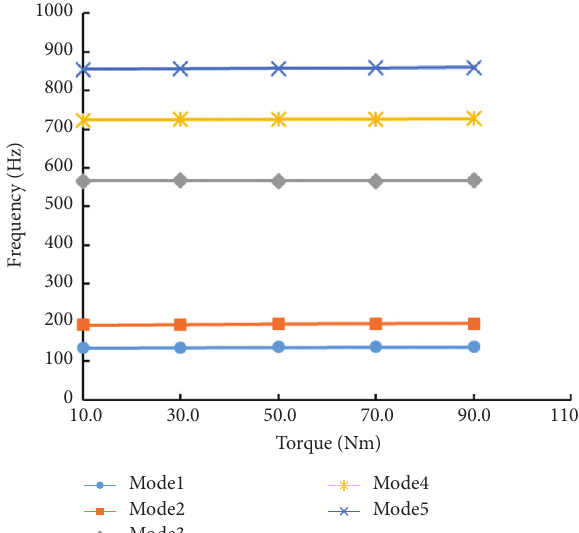
Figure 7: Modal testing results of Case 2: natural frequency versus preload on M20 bolt.